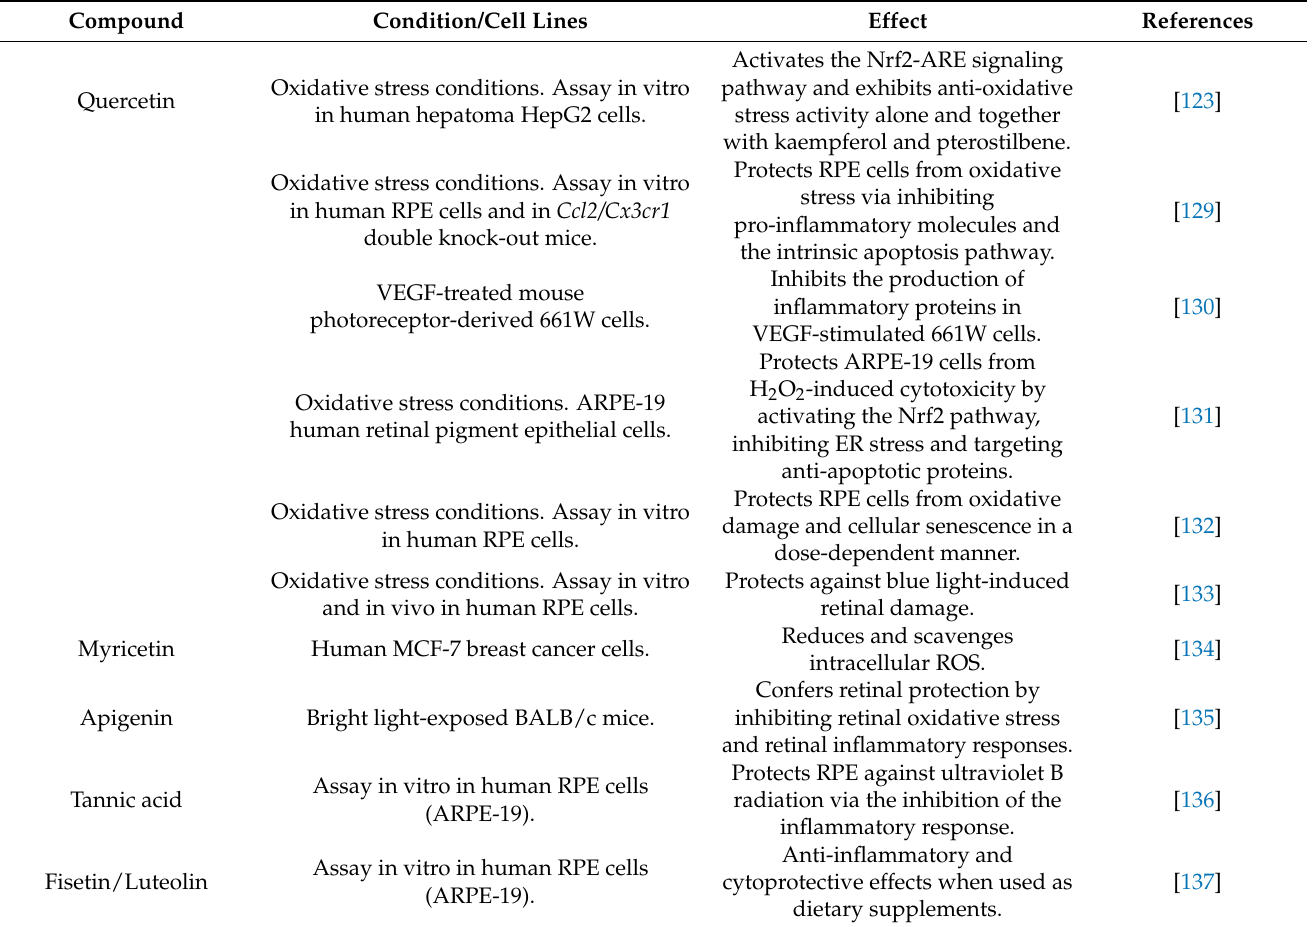
Table 2. Summary of different polyphenols effects on retinal